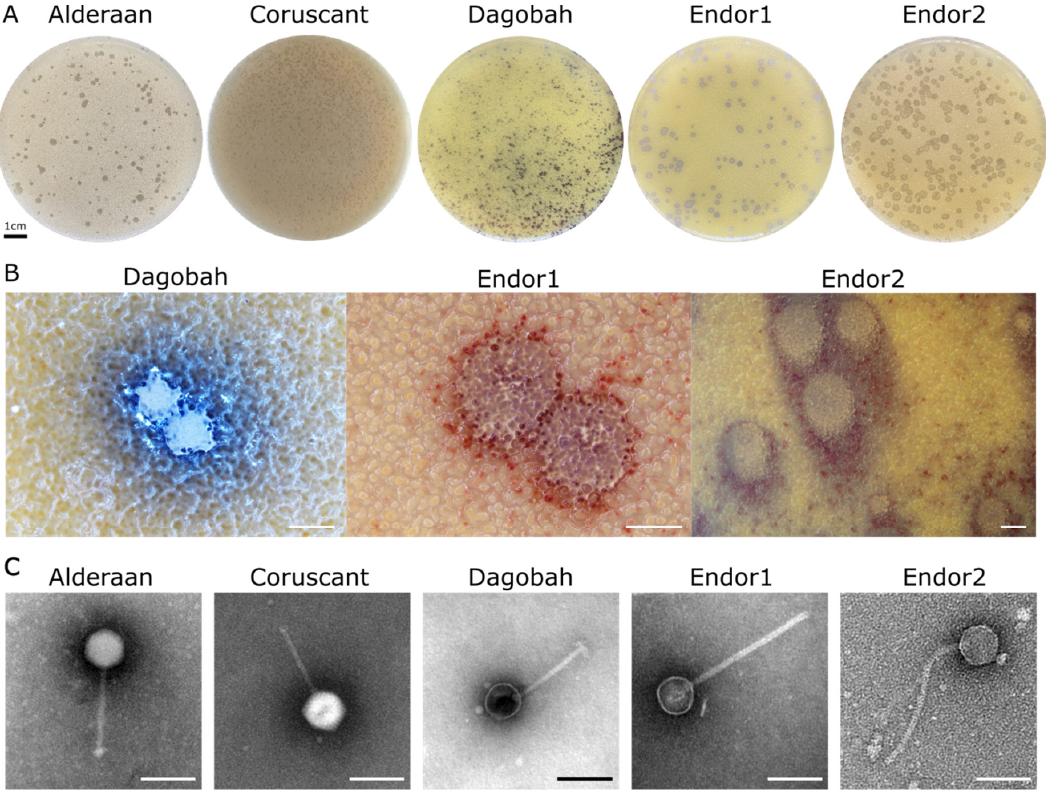
Figure 1. Morphology observation of five novel Streptomyces phages. ( A ) Plaque morphologies of the five phages. Double agar overlays were performed to infect S. venezuelae ATCC 10712 with the phages Alderaan and Coruscant, and S. coelicolor M600 with the phages Dagobah, Endor1, and Endor2. Plates were incubated overnight at 30 ◦ C and another day (3 days in the case of Dagobah) at room temperature to reach full maturity of the bacterial lawn. ( B ) Close-ups of phage plaques imaged using a stereomicroscope Nikon SMZ18. S. coelicolor M145 was infected by phages using GYM double agar overlays. The plates were incubated at 30 ◦ C overnight and then kept at room temperature for two (Endor1 and Endor2) or three days (Dagobah). Scale bar: 1 mm. ( C ) Transmission electron microscopy (TEM) of phage isolates. The phage virions were stained with uranyl acetate. Scale bar: 150